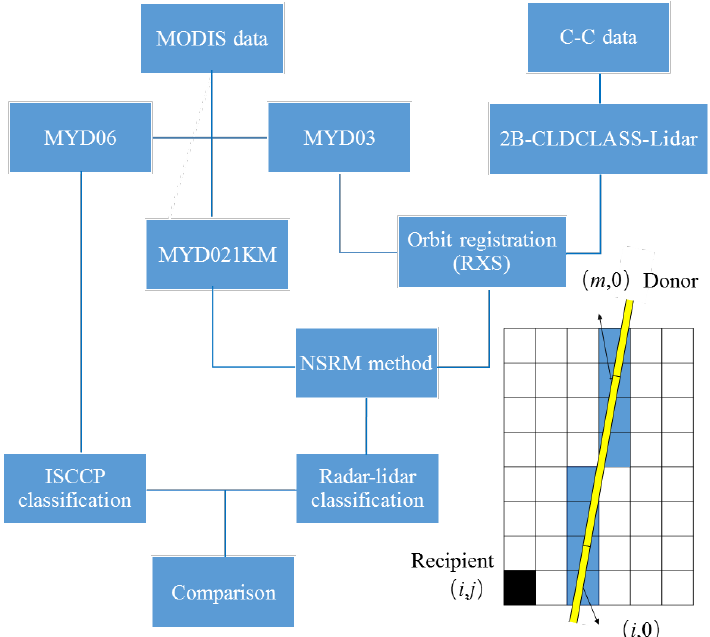
Figure 1. Flowchart of the This nighttime spectral radiance matching (NSRM) method and the verification process in this work. In the demonstration of orbit registration, the yellow line indicates the track of CloudSat, while the grids are pixels of Moderate Resolution Imaging Spectroradiometer (MODIS).